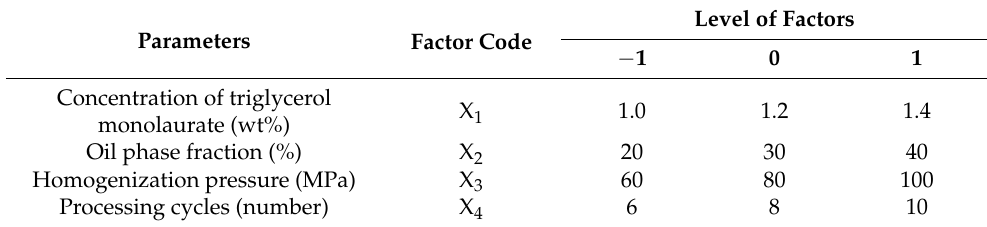
Table 3. The main factors and the corresponding levels.